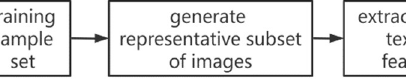
Figure 2. The process of the method.